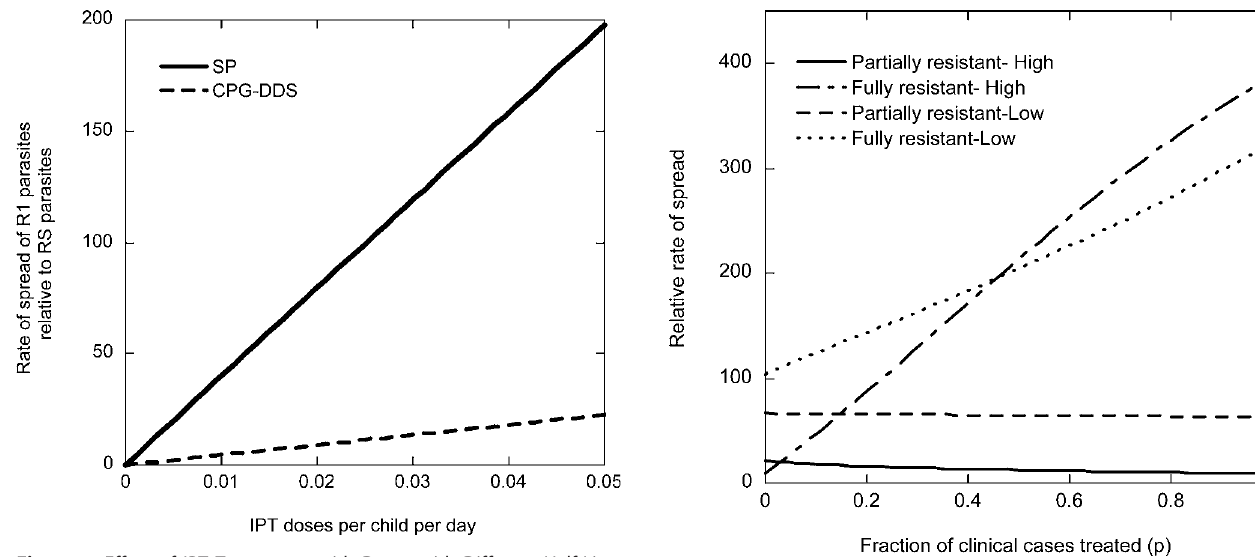
Figure 6. Effect on the Spread of R1 and R2 Resistance of Increasing the Proportion of Infected Individuals Who Are Treated Increasing drug usage in cases of true infection does not affect the spread of R1 but can select for R2 parasites if they are already present. DOI: 10.1371/journal.pmed.0030141.g006